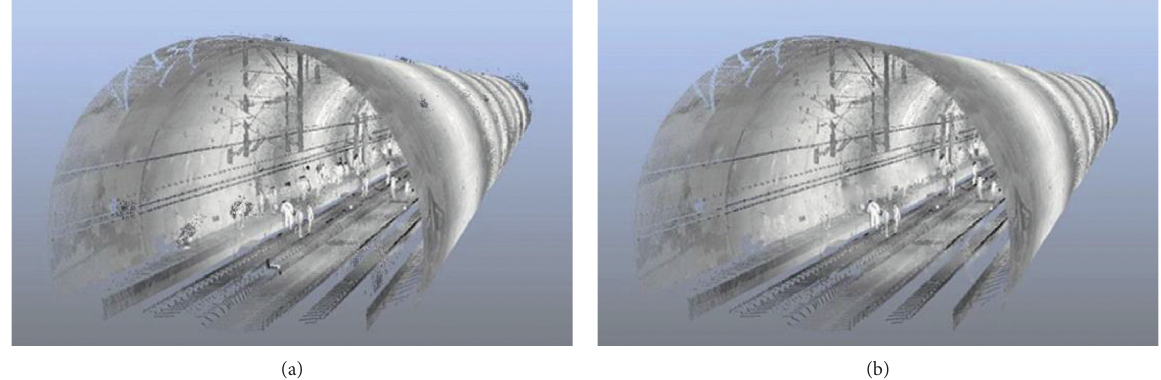
Figure 11: Noise reduction processing effect. (a) Original cloud map. (b) Noise reduction cloud